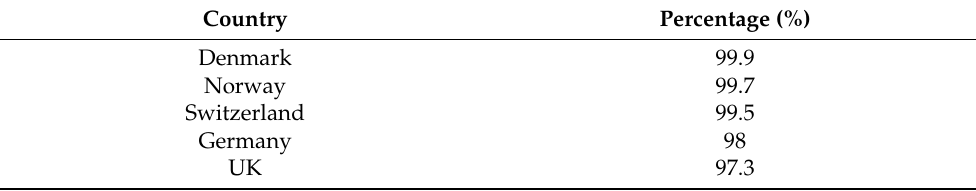
Table 1. Network coverage of DAB+ (as a percentage of